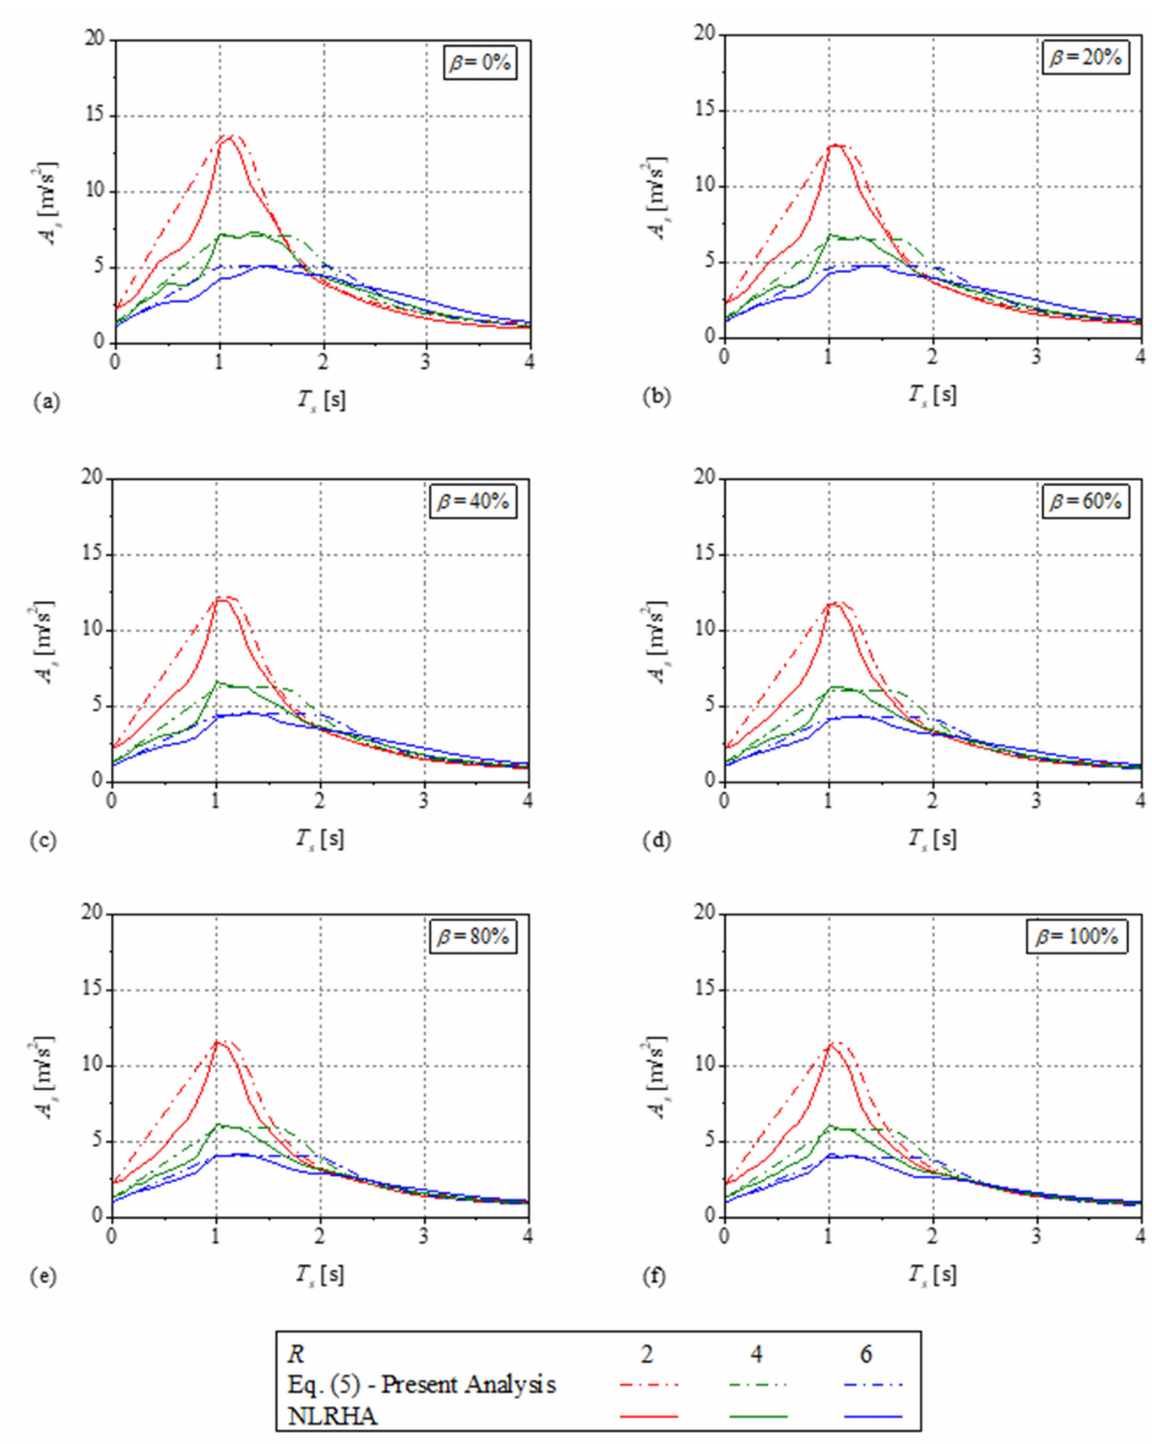
Figure 8. Comparison of the mean floor response spectra from Equation (5) and NLRHA for a primary structure with initial vibration period T p = 1.0 s, post-yield stiffness ratio α = 5%; viscous damping ratio ξ p = 5%; and a secondary structure with viscous damping ratio ξ s = 5%: ( a ) β = 0%; ( b ) β = 20%; ( c ) β = 40%; ( d ) β = 60%; ( e ) β = 80%; and ( f ) β =